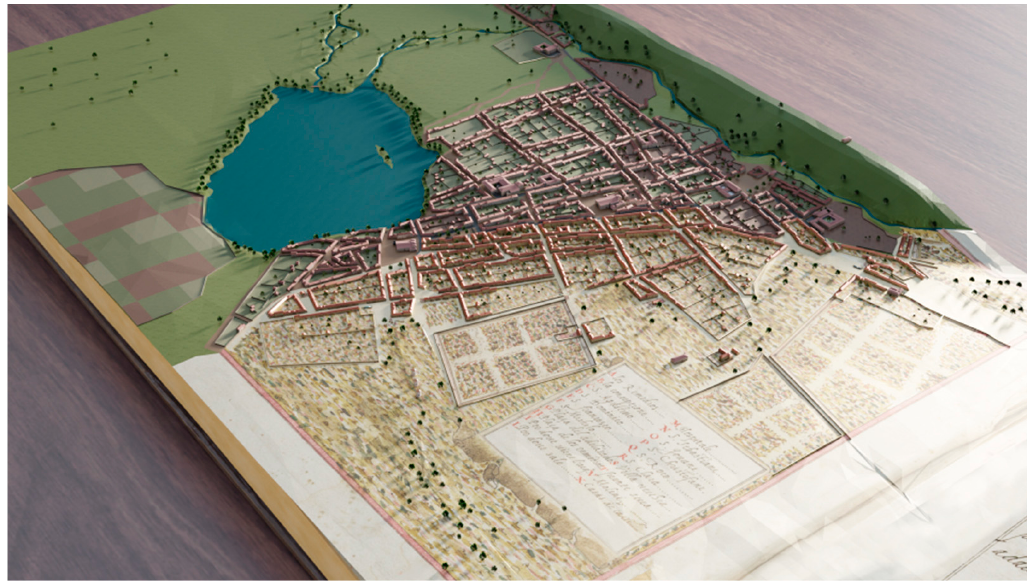
Figure 24. City reconstruction combined with Torriani’s map.